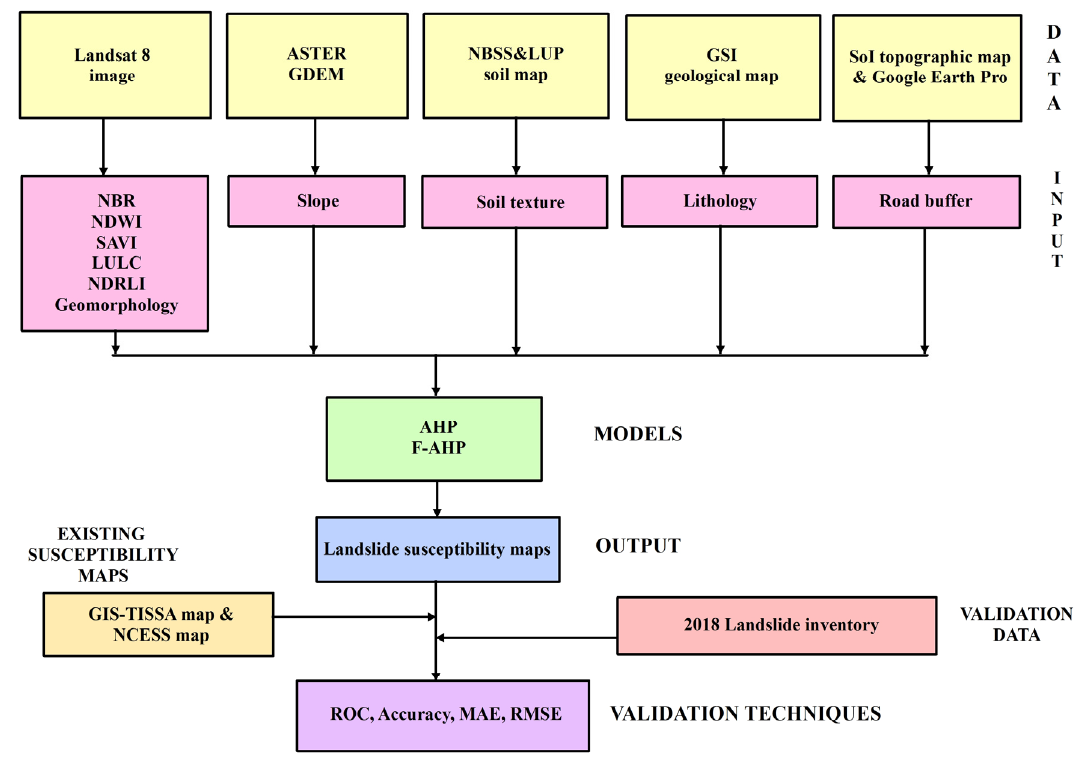
Figure 3. Flowchart of the landslide susceptibility modeling. Table 1. Data sources.